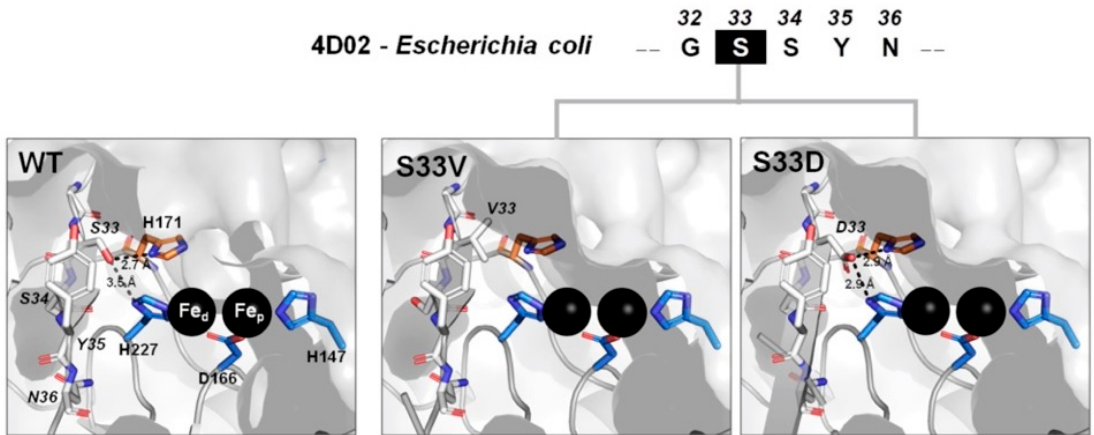
Figure 5. Homology-based model of the S33V and S33D mutants. The interaction of residue 33 with the surrounding residues is shown for the structure of the WT enzyme. The figure was built with PyMOL using (from left to right) the X-ray structure for the WT protein (PDB code: 4D02) and the structures corresponding to the best models generated for the mutants S33V and S33D. The protein’s secondary structure elements are shown using a gray cartoon representation and the molecular surface is also represented in gray. For simplicity, only the residues His227, Asp166 and His147, which were part of the coordinating sphere of the metal center, are displayed, using sticks with the carbons colored in blue and the iron atoms as black spheres, labeled as proximal Fe (Fe p ) and distal Fe (Fe d ). The distances between residue 33 and histidines 171 and 227 are represented by dashed lines and labeled with the corresponding values.